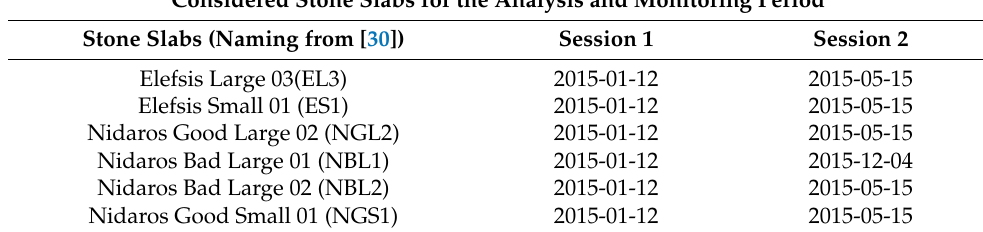
Table 8. Stone-slab labeling and two chosen sessions of data collection. Considered Stone Slabs for the Analysis and Monitoring Period Stone Slabs (Naming from